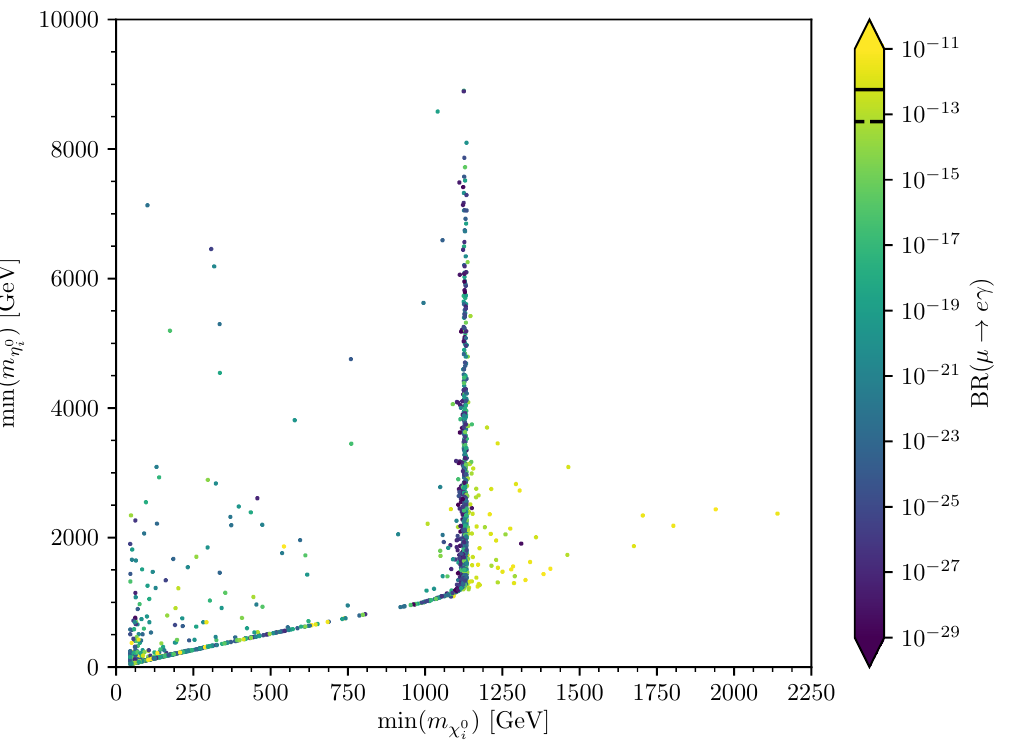
Figure 8 . The lightest neutral scalar vs. the lightest neutral fermion mass for viable models with singlet-doublet fermion DM. Also shown is the branching ratio for the LFV process (cid:22) current (full line) and future (dashed line) exclusion limits [41,